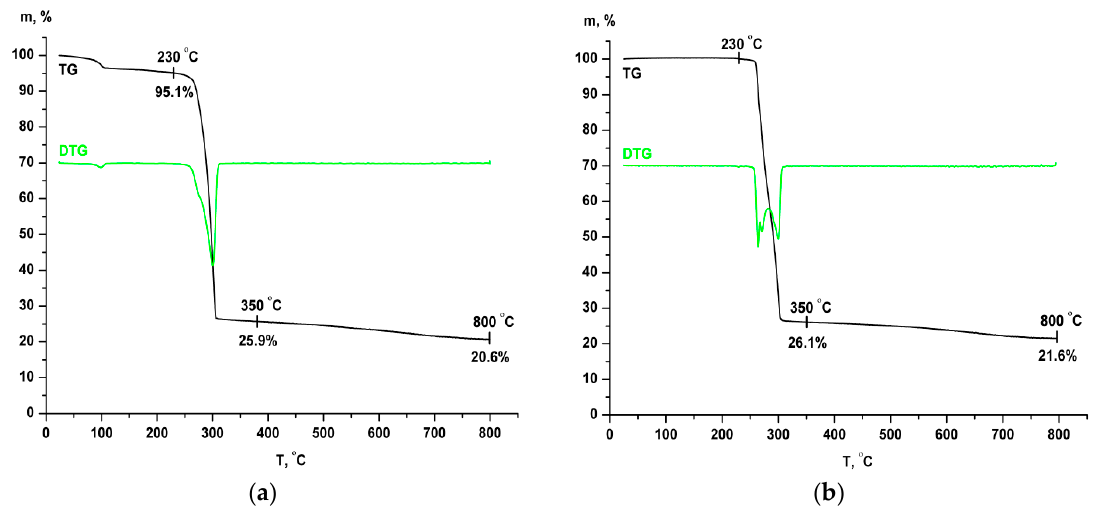
Figure 5. Curves of thermal analysis in inert atmosphere for complexes 1 ( a ) and 2 ( b ).